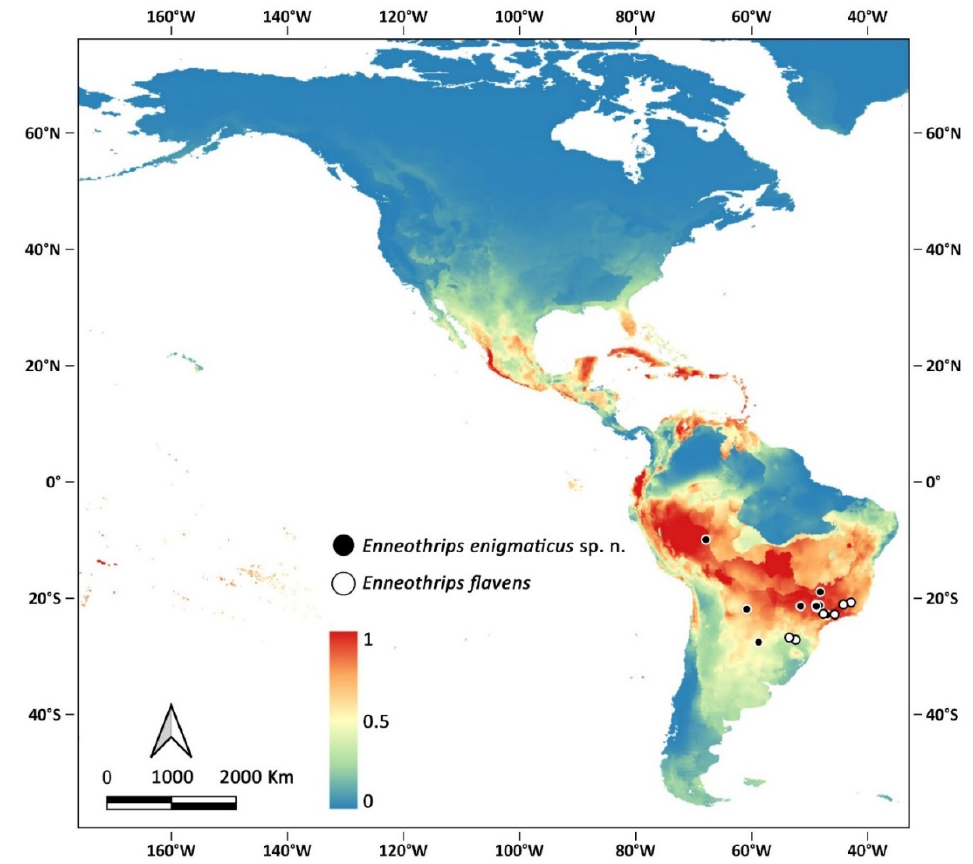
Figure 6. Confirmed records of Enneothrips spp. (circular markings) and modelling distribution of Enneothrips enigmaticus sp. n. in the Americas.